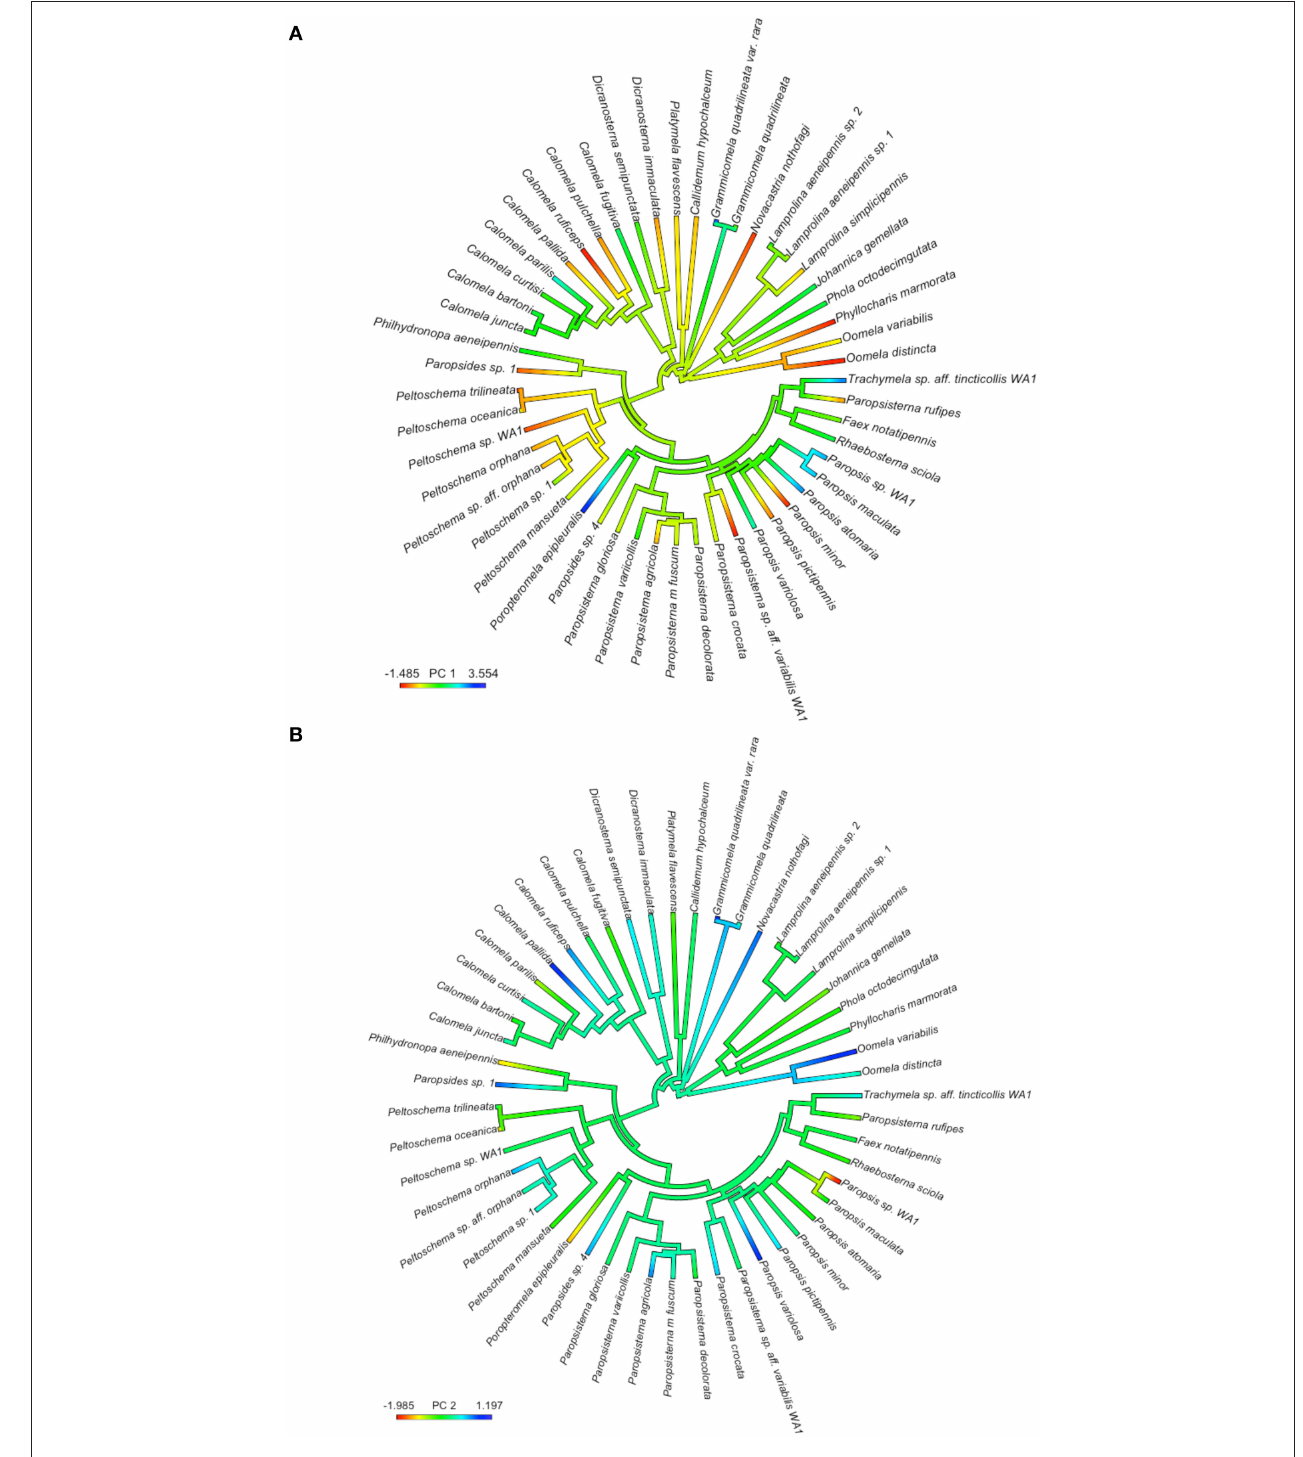
FIGURE 4 | Species values of principal components from the phylogenetic principal components analysis of differences in red, green and blue patterns between beetles and host plants, mapped onto the phylogeny of the chrysomelines. Color on the heat map represent PC1 (A) and PC2 (B) values of species (see legend for scale) but do not represent the actual color of the